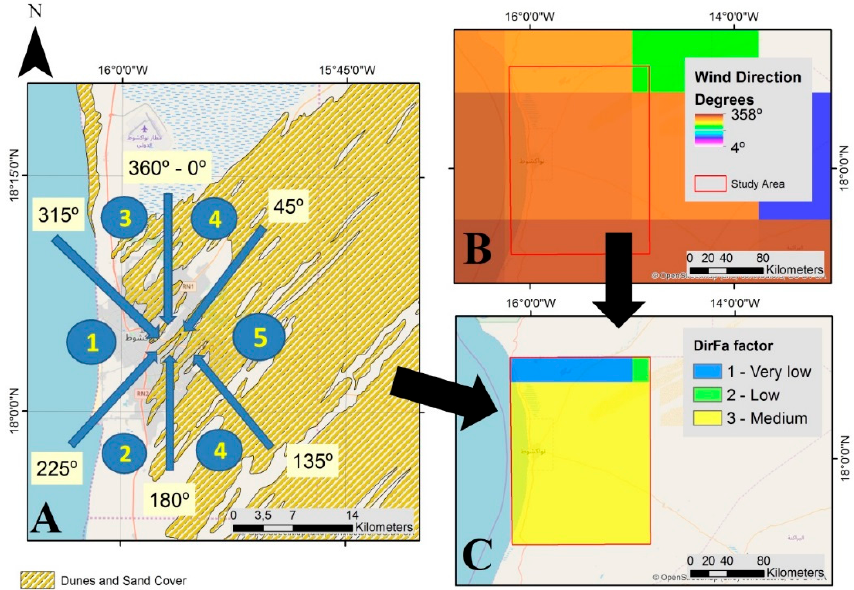
Figure 3. ( A ) Vulnerability of Nouakchott if the wind blows from each of the angle ranges displayed in the graph. The numbers represent the assigned vulnerability level in accordance with the sand dune map, ( B ) wind direction map of the study area and ( C ) vulnerability map according to the wind direction factor.